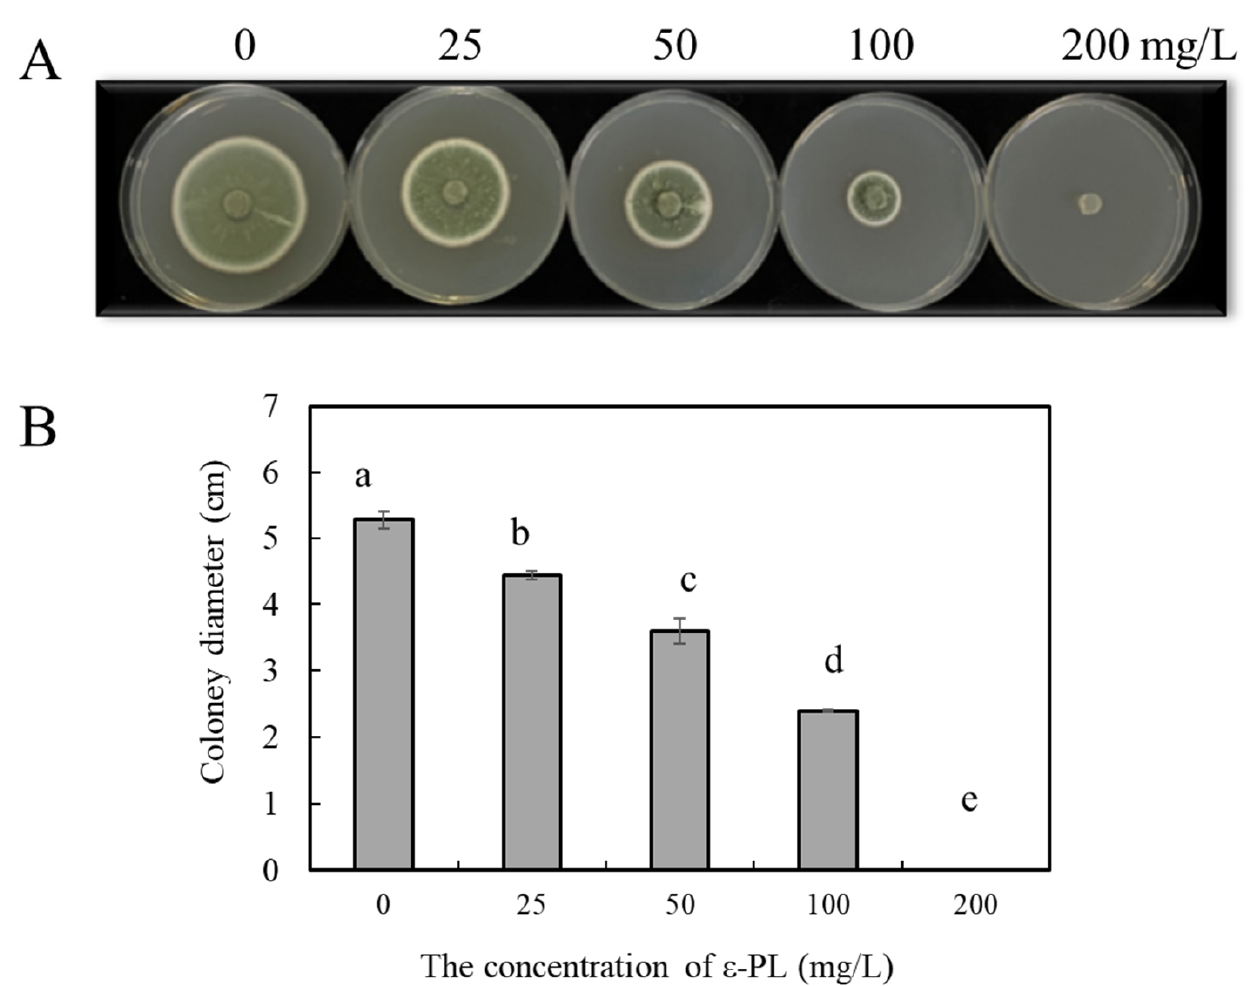
Figure 1. Effect of ε -PL treatment on the growth of P. expansum in vitro. ( A ) Colony growth and ( B ) colony diameter of P. expansum cultured for 6 days. The data are shown as mean ± SD, n = 3. According to Tukey’s test, different letters indicate significant differences ( p < 0.05).